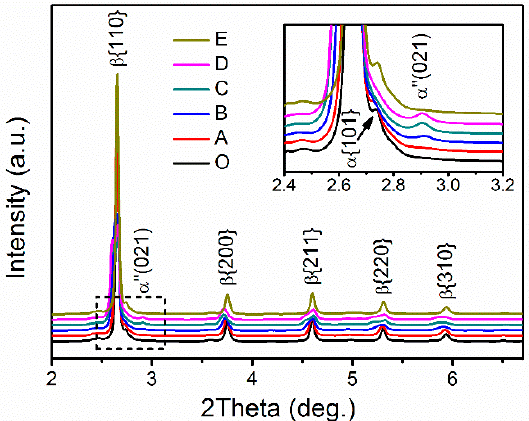
Figure 7. One-dimensional SXRD spectrums integrated over the entire 360° at different applied strains corresponding to points O–E in Figure 3b. Inset shows the enlarged view of the boxed area in the spectrums.